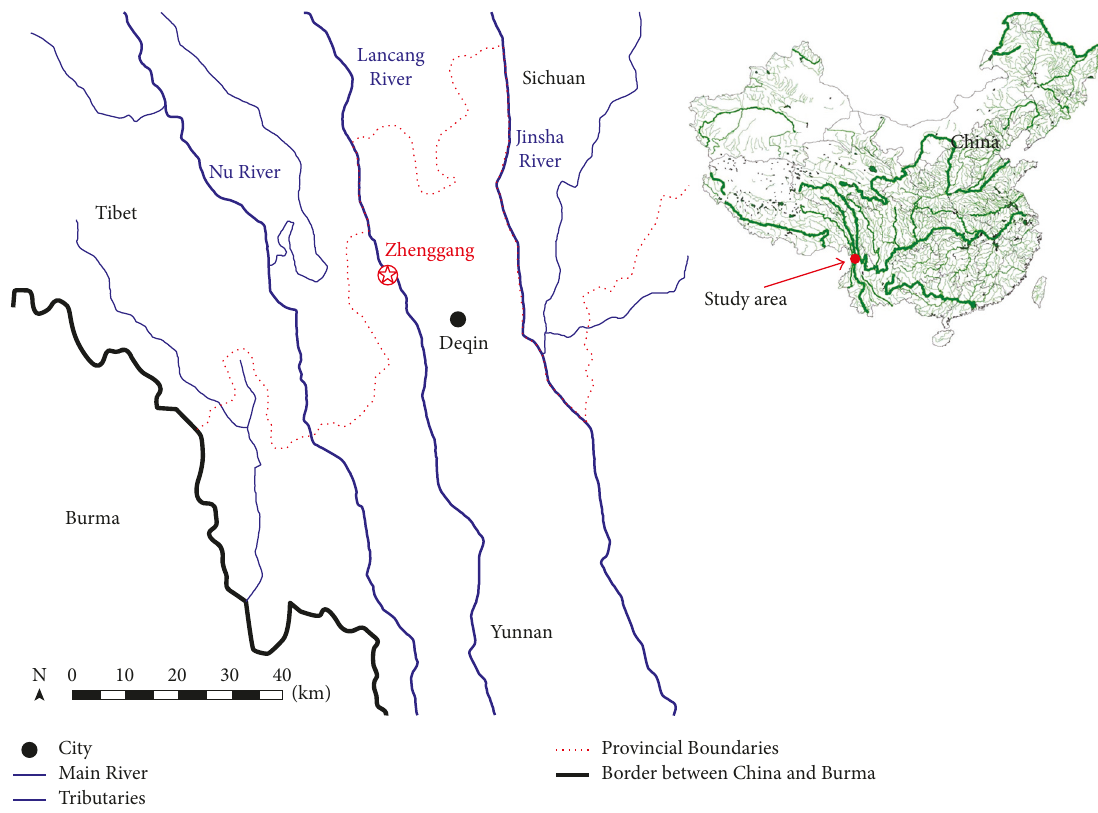
Figure 1: Site location of the Zhenggang landslide.